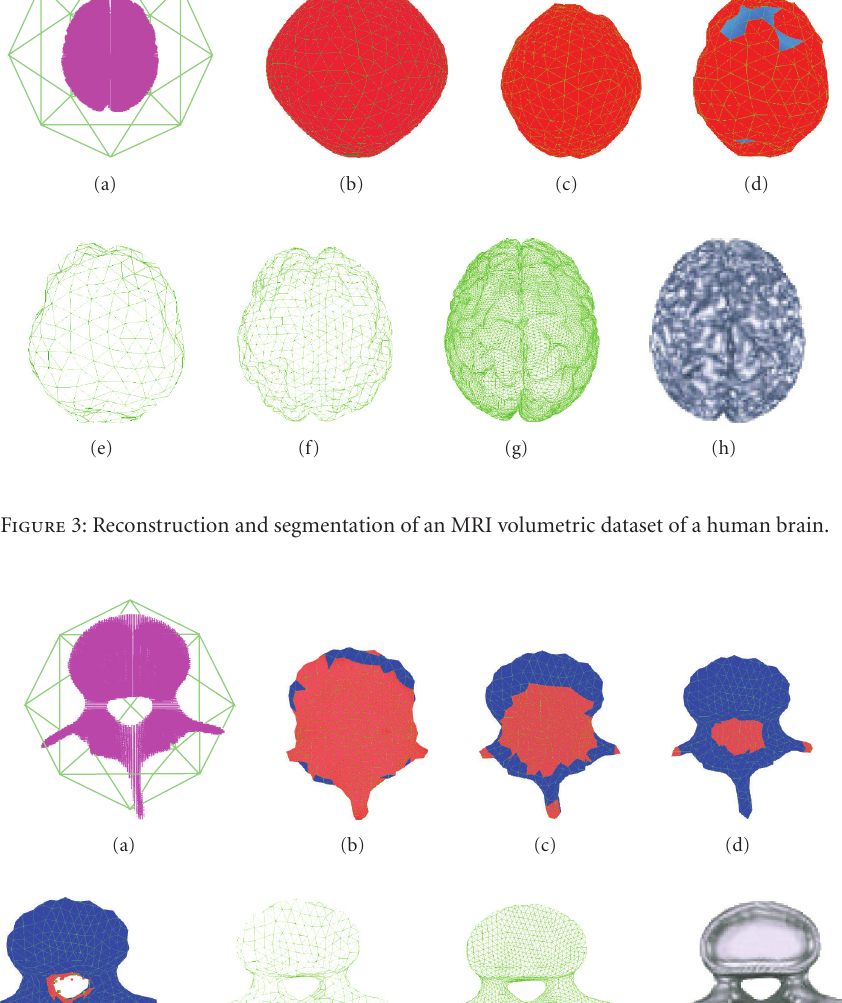
points). Figure 3(b) to Figure 3(d) are the three snapshots during the deformation process. Figure 3(e) is the wireframe view of the initial recovered shape. Figure 3(f) is the shape after one level of global refinement. Figure 3(g) is the shape after another level of adaptive refinement. Figure 3(h) is the rendered view of the same model of Figure 3(g). The in- put dataset of Figure 4 is obtained from CT scanning of a phantom of the vertebra. The data size is 128 by 120 by 52 voxels. Figure 4(a) is the model initialization stage with the seed model enclosing the volumetric dataset. The four fig- ures Figure 4(b) to Figure 4(e) are the snapshots of the model while they are still deforming, we can see that the